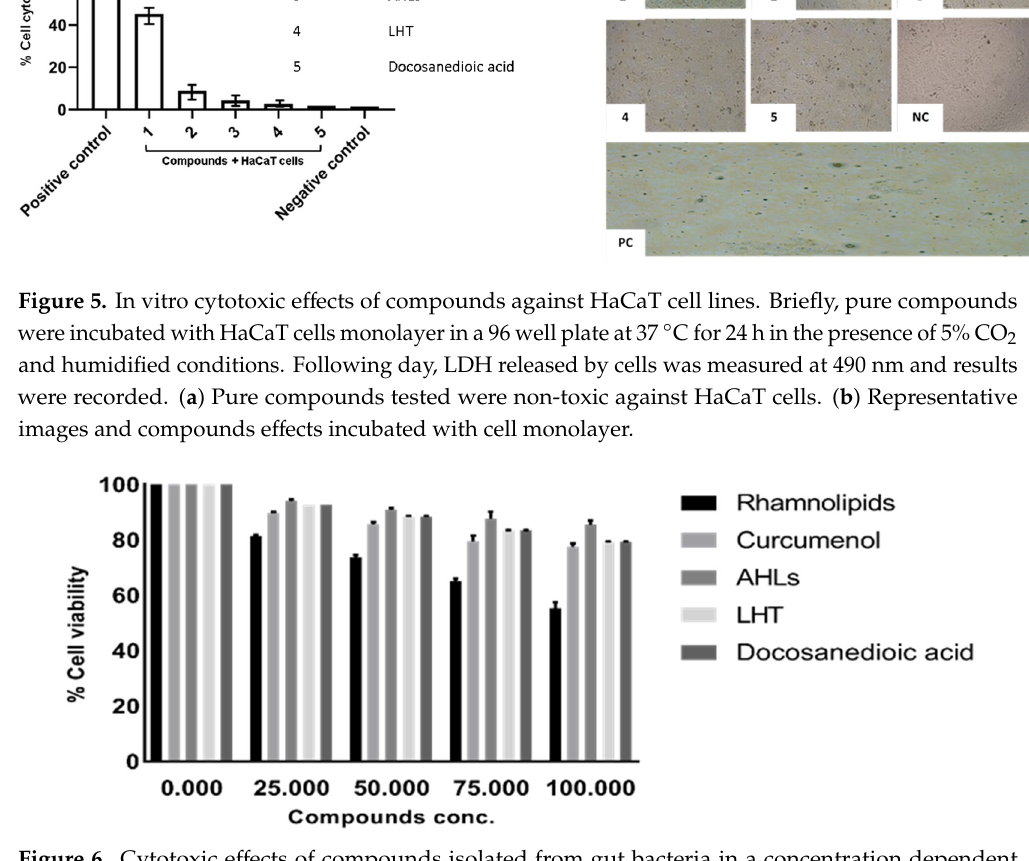
Figure 6. Cytotoxic effects of compounds isolated from gut bacteria in a concentration dependent manner on HaCaT cell viability using MTT assays. Briefly, overnight grown confluent HaCaT cells monolayer was exposed to different concentration of the compounds in a 96-well plate and plate was incubated at 37 °C for 24 h in the presence of 5% CO 2 and humidified conditions. HaCaT cells alone was taken as negative control. All data are expressed as the mean ± standard error of three independent experiments performed in duplicates. Data was analyzed using GraphPad prism software version 8.0.2.